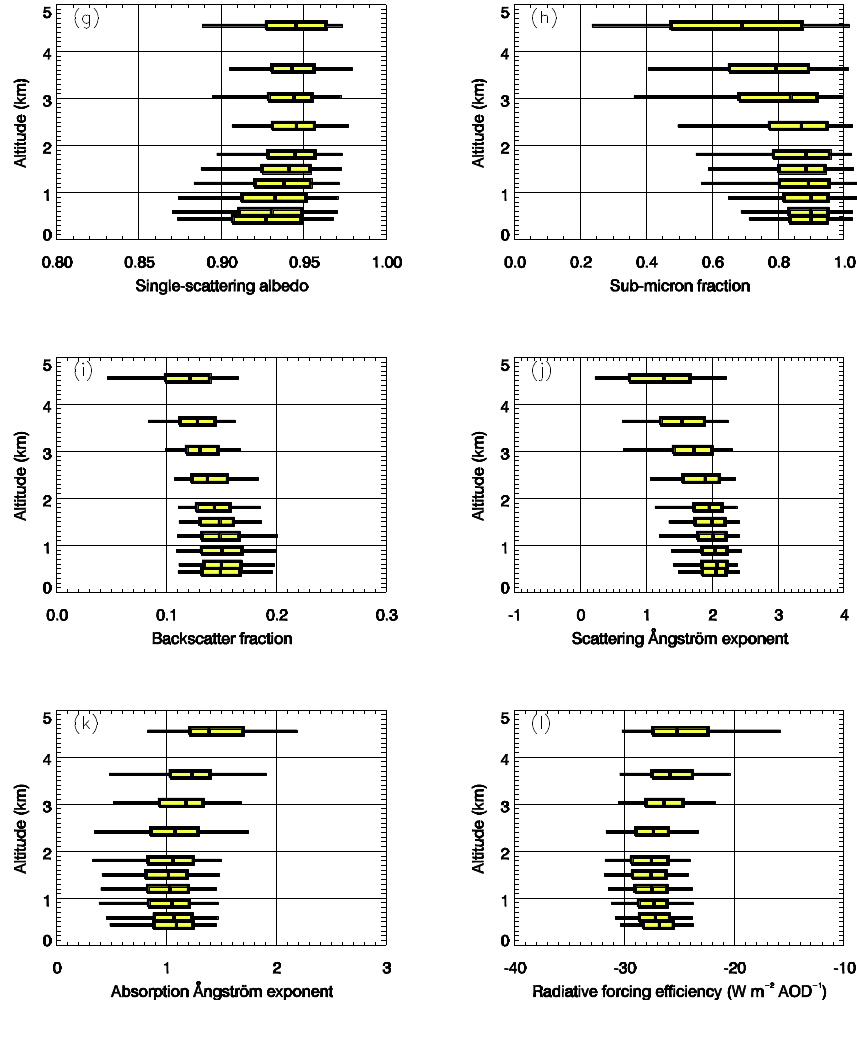
Fig. 8(g-l). Cumulative statistics of measured and calculated parameters for all AAO research profiles. Aerosol measurements are for dry (RH ≤ 40%) conditions and are adjusted to ambient temperature and pressure, with the exception of the CN concentration, which is reported at instrument temperature and pressure (volume flow rate